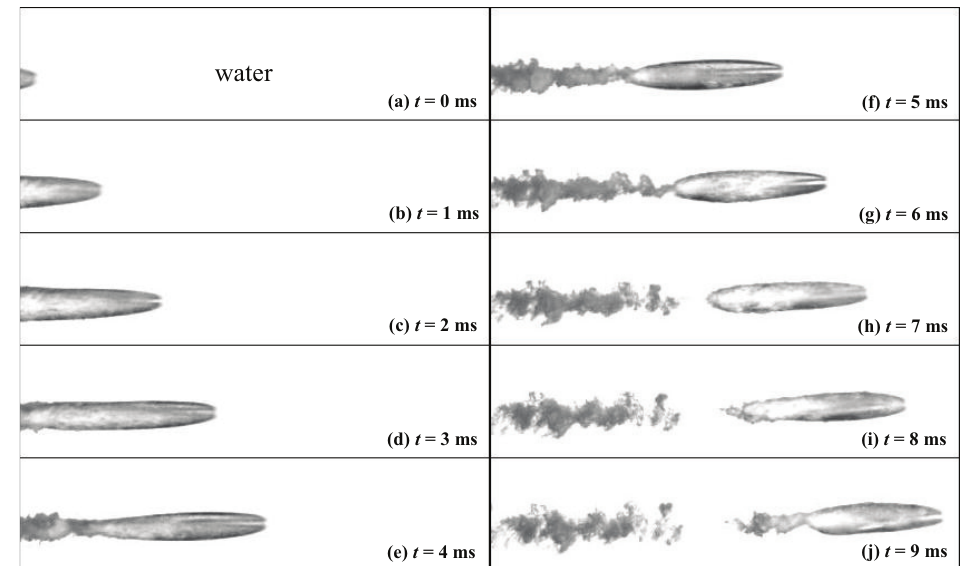
Figure 7. Supercavitation evolution of the projectile with hydrophilic coating under the water depth of 16.7D ( ∆ t = 1 ms, V 0 = 38.4 m/s).